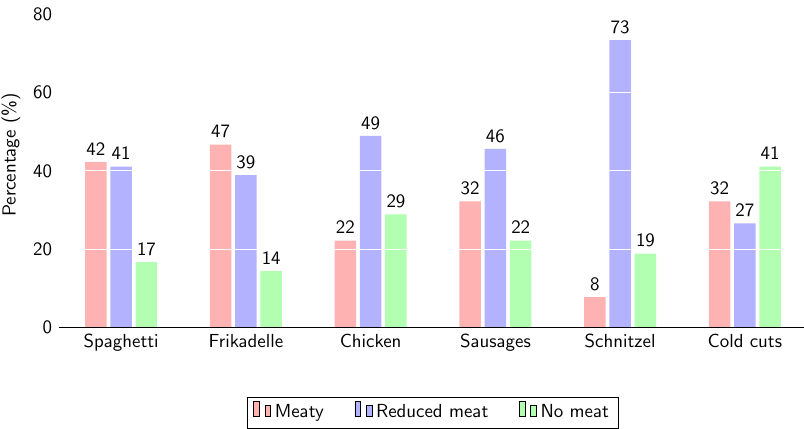
Figure 4. Proportions (in %) of participants choosing the preferred variety (meaty, reduced meat, no meat) of a dish (Spaghetti, Frikadelle, Chicken drumsticks, sausages, Schnitzel, cold